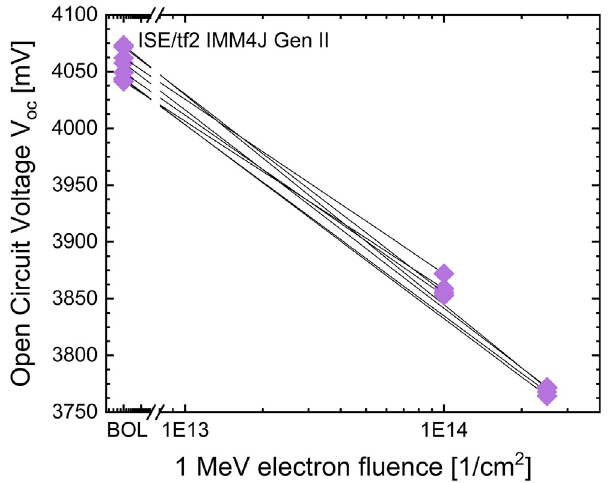
Fig. 8. The open circuit voltages for BOL and soft irradiation conditions of different IMM4J solar cells from the same MOVPE run. They degraded on average 220 mV after an irradiation with 1 MeV electrons after a fl uence of 1 (cid:1) 10 14 e – /cm 2 and about 270 mV after 2.5 (cid:1) 10 14 e – /cm 2